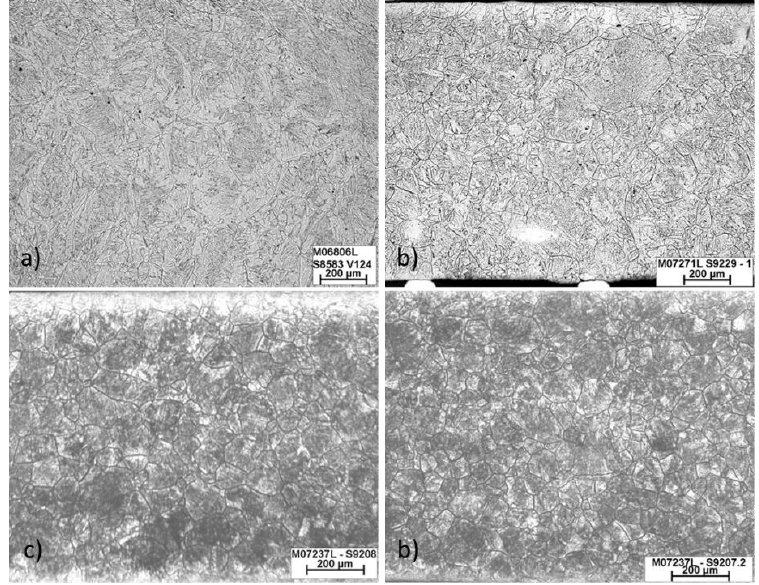
Figure 3. PAGB’s revealed by saturated aqueous solution of picric acid for ( a ) Production produced Base CASTRIP, ( b ) base grade (CCT work), ( c ) 0.04% Nb (CCT work) and ( d ) 0.08% Nb (CCT